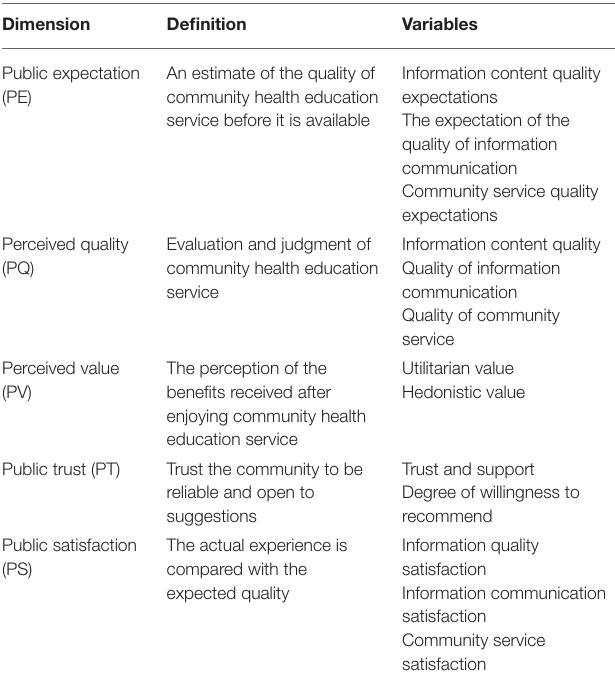
TABLE 1 | Five dimensions of satisfaction with community health education and their definitions and key variables.